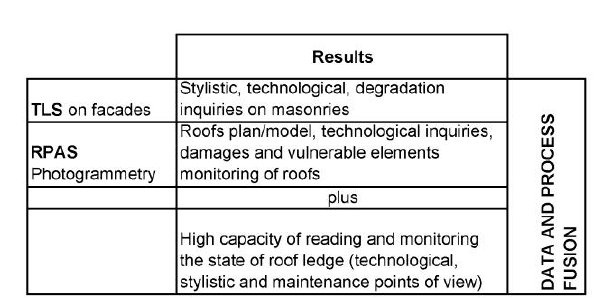
Table 2. Abilities of data and process